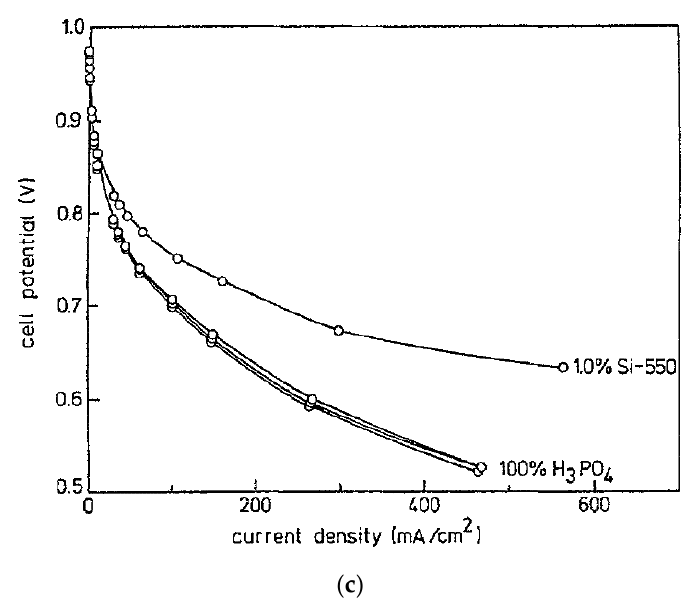
Figure 3. Polarization curves showing the effect of various wt % of C 4 and C 6 salt ( a ); C 4 amine ( b ); and Si-550 ( c ) on phosphoric acid fuel cell (PAFC) performance operating at 190 ◦ C on H 2 /O 2 (Reproduced from [123] with permission; Copyright ECS, 1993).